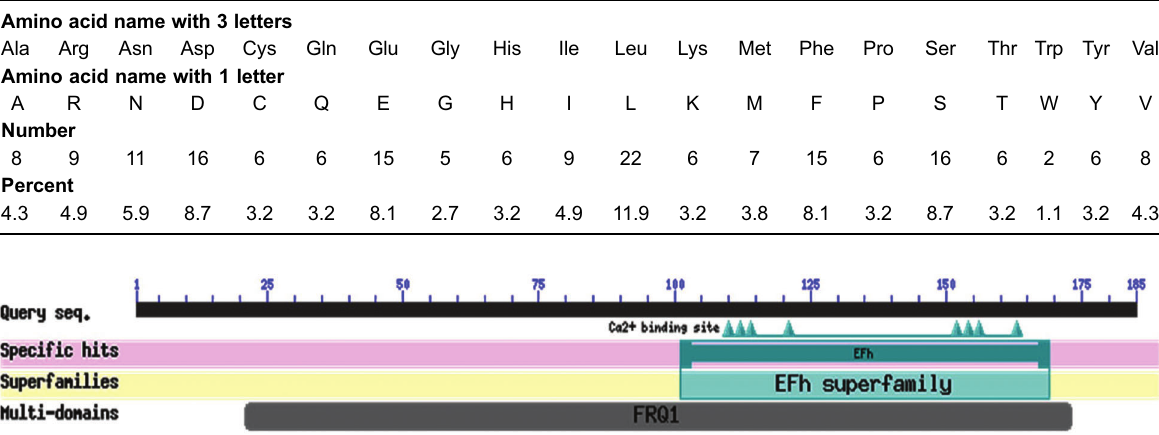
Figure 5. The predicted domain of Kermani sheep CIB4 protein. EFh domains range from amino acid 101 to 171, including a switch region I starting from the amino acid 101 to the amino acid 129 and a switch region II from amino acid 143 to